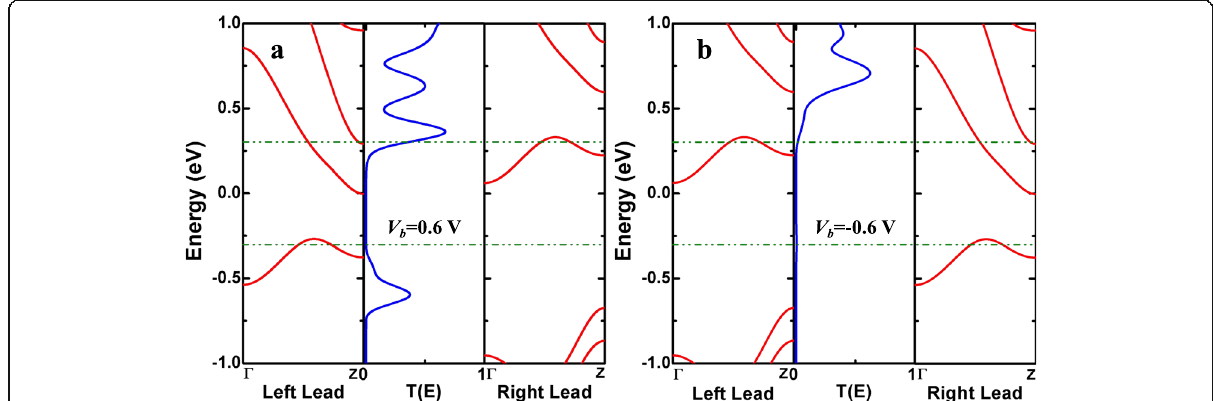
Fig. 7 (Color online) The spin-up band structures of the left/right leads and the spin-up transmission spectra of A γ GYNRs with single N-doping at the adjoining position for M 2D under the biases of a 0.6 and b − 0.6 V. The region between the double horizontal green dashed lines is the